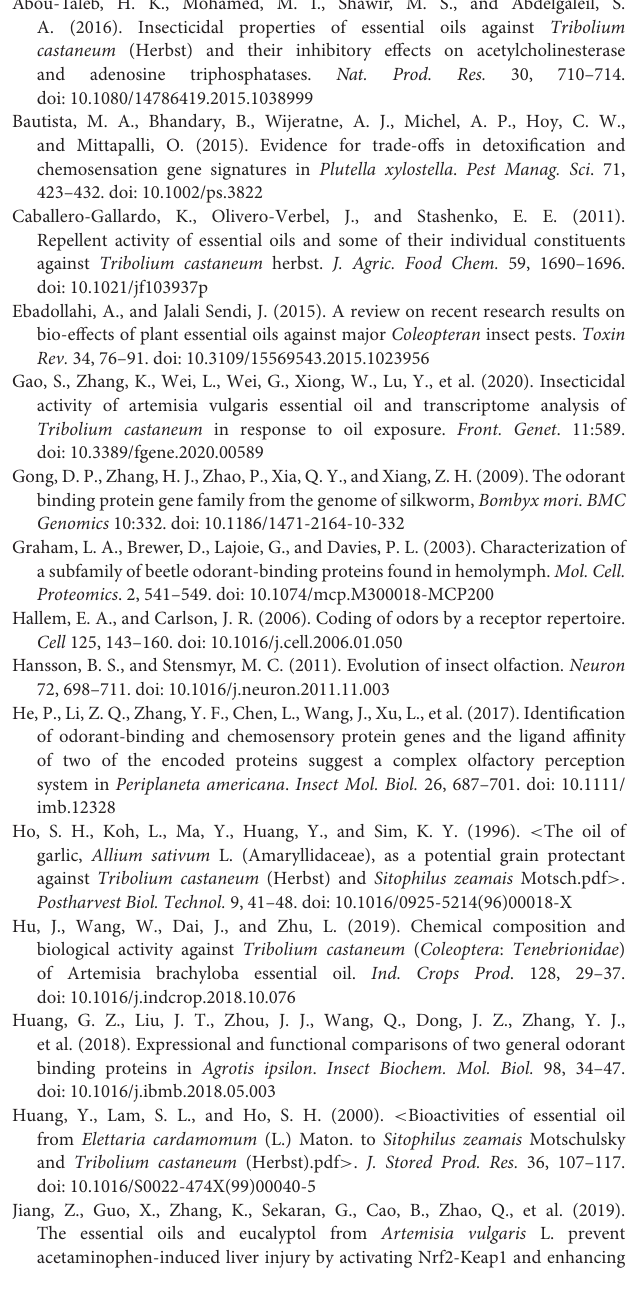
Supplementary Figure 2 | The phylogenetic tree of TcOBPC17 and other OBP sequences reported in other insects. The phylogenetic tree was constructed with the neighbor-joining method using MEGA 6.1 software. Bootstrap values (2,000 replicates) are displayed next to the branches of the phylogram. The GenBank accession numbers, full gene names, and scientific names of these insects are exhibited behind the branches of the phylogram. Supplementary Table 1 | Primers used in this